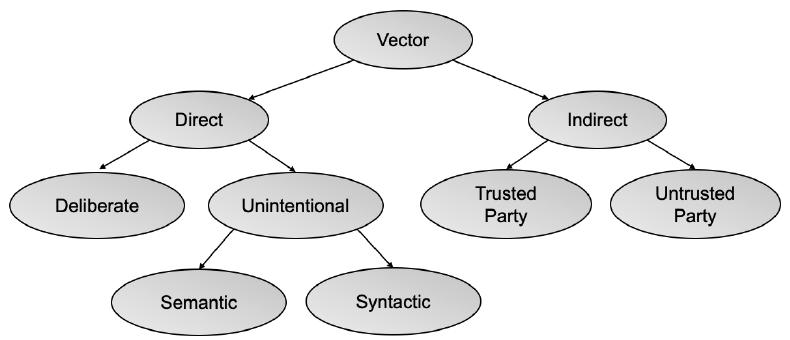
Figure 3. Delivery Vectors’ taxonomy.